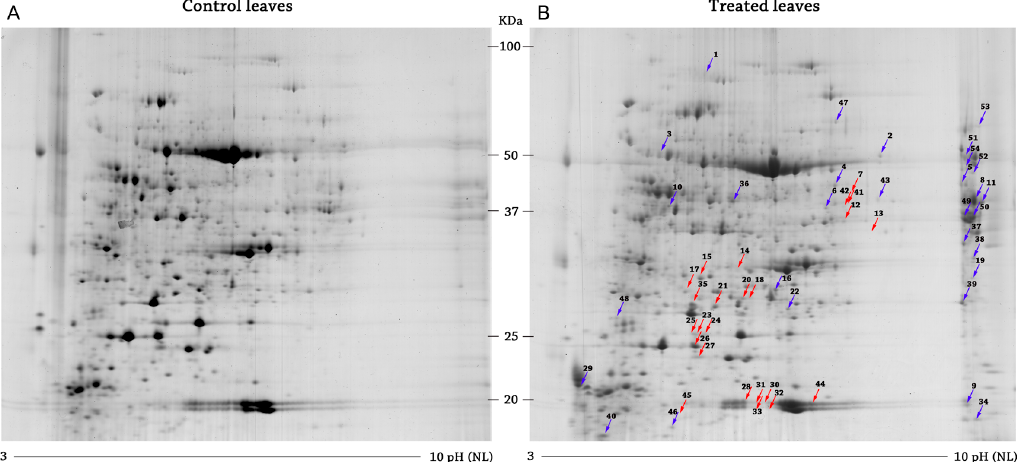
Figure 1. Representative reference 2-DE gels of Arabidopsis control ( A ) and treated ( B ). Gels were colored by colloidal Coomassie blue staining. The Progenesis SameSpot software package was used for gels analysis. The differential proteins are identified by arrows: in red, the down-expressed spots in; in blue, the over-expressed spots in cerato-platanin (CP)-treated leaves. NL, non-linear.